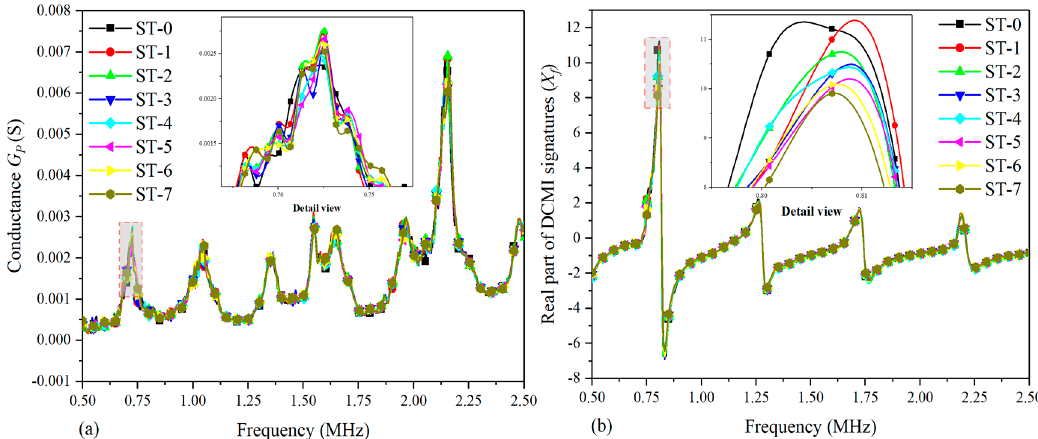
Figure 9. Comparative plots based on real part of signatures for specimen-2: ( a ) raw conductance signatures G P , ( b ) extracted DCMI signatures X f .